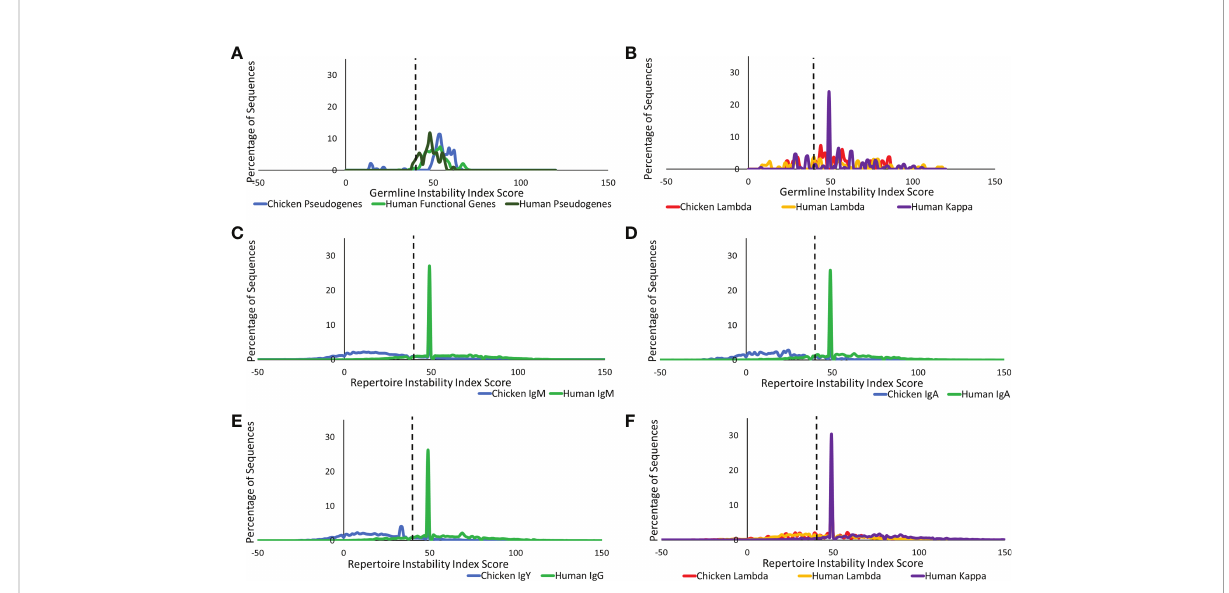
FIGURE 10 Comparison of protein instability of germline variable genes between (A) chicken pseudogenes, human functional genes, and human pseudogenes at the heavy chain loci and (B) chicken pseudogenes, human lambda functional genes, and human kappa functional genes at the light chain loci. Comparison of the protein binding potential between repertoire sequences shows (C) chicken IgM against human IgM, (D) chicken IgA against human IgA, (E) chicken IgY against human IgG, and (F) chicken lambda light chain sequences against human lambda light chain sequences and human kappa light chain sequences. Protein instability index score calculated by BRepertoire online immunoglobulin repertoire analysis tool using the CDR3 region amino acid